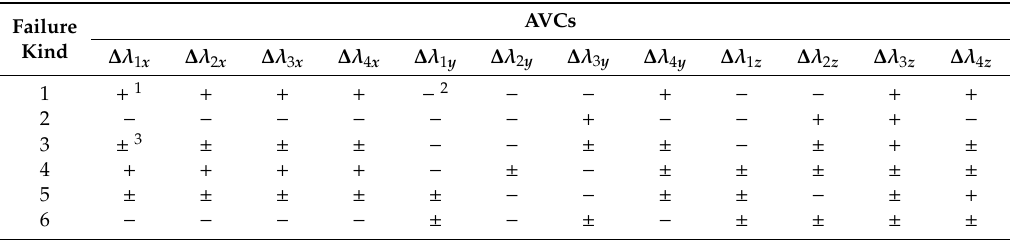
Table 3. The influence rules among sti ff ness variation coe ffi cients (SVCs) and amplitude variation coe ffi cients (AVCs) with six kinds of spring